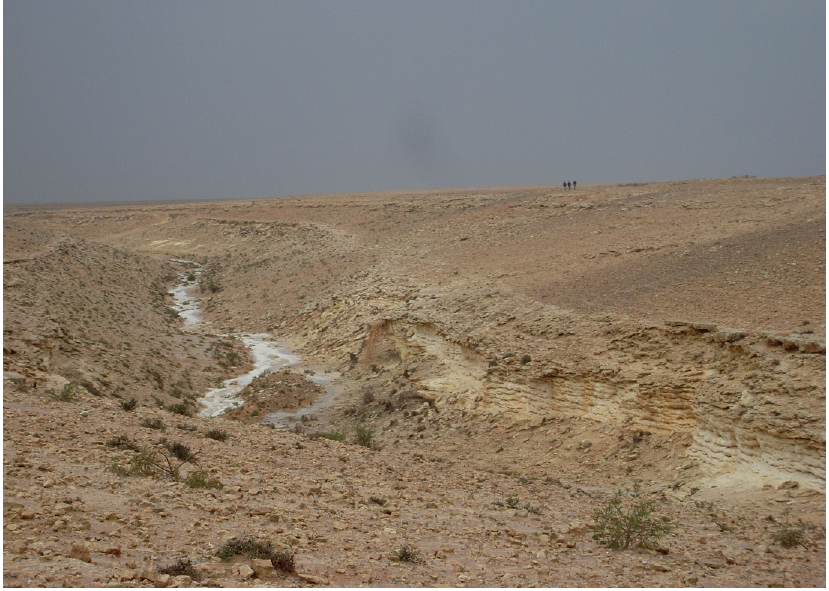
Fig. 3. The wadi incisions make the terrain of the Northern Tableland difficult to pass through, as here in Wadi Umm el-Ash- dan, 25 km west of Marsa Matruh/Paraitonion, with water from winterly precipitations running down to the Mediterranean Sea. (Florian